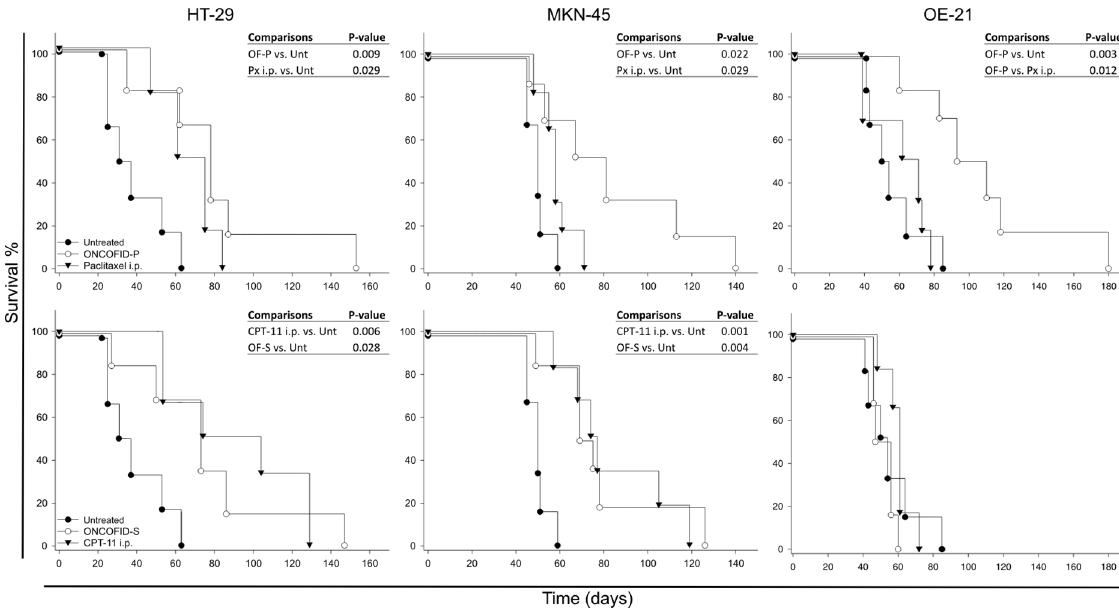
Figure 6. Invivo therapeutic activity of bioconjugates. Kaplan-Meier survival curves of mice with peritoneal carcinomatosis from HT-29, MKN- 45 or OE-21 tumor cells. Animals were randomly assigned to an experimental group and drug treatment was initiated according to therapeutic schedule reported in Materials and Methods. All experimental groups were statistically compared each other, but only significant values are reported in each panel.